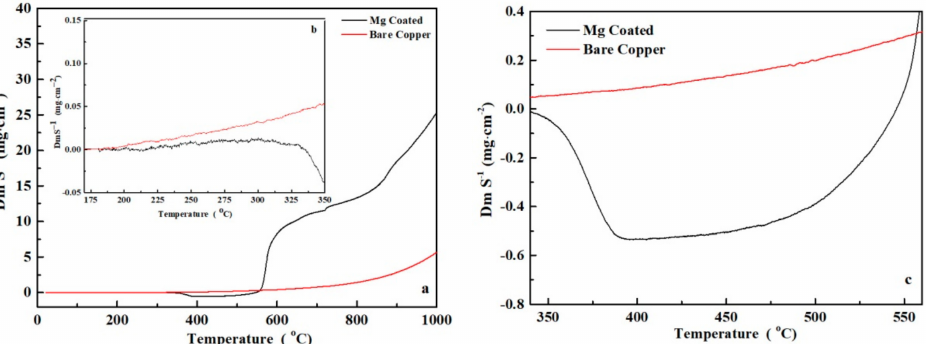
Figure 3. Mass gain graph of Mg coated and copper samples, after dynamic oxidation from room temperature up to 1000 ◦ C ( a ) and focused graphs on the areas of interest ( b , c